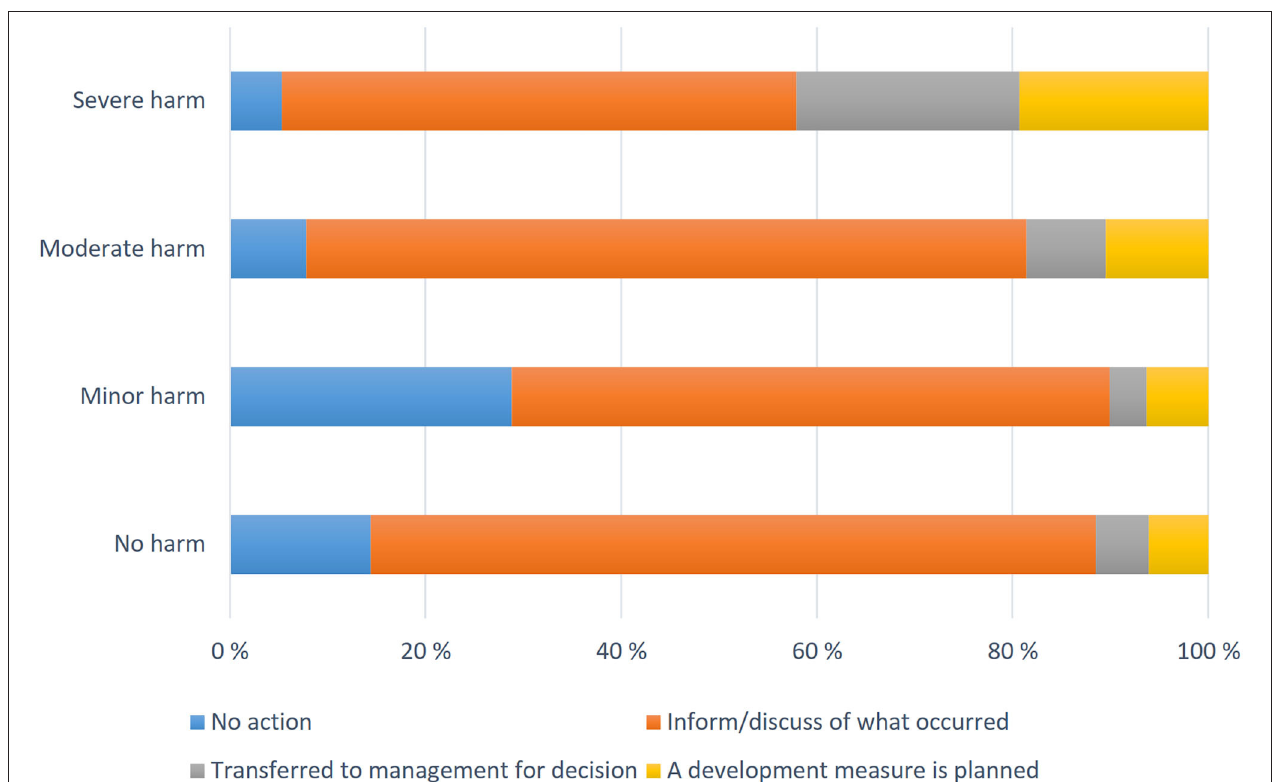
FIGURE 4 | Reported patient harms with proposed measures in 2007–2017 in